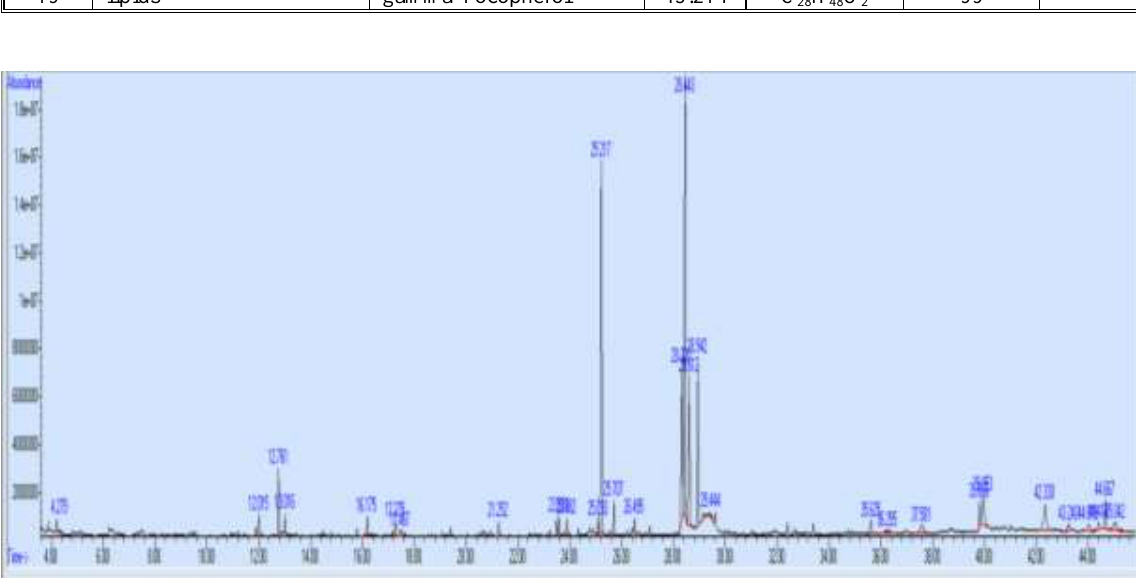
Figure 4. GC-MS analysis of petroleum ether leaves extract of Leucaena leucocephala by cold extraction